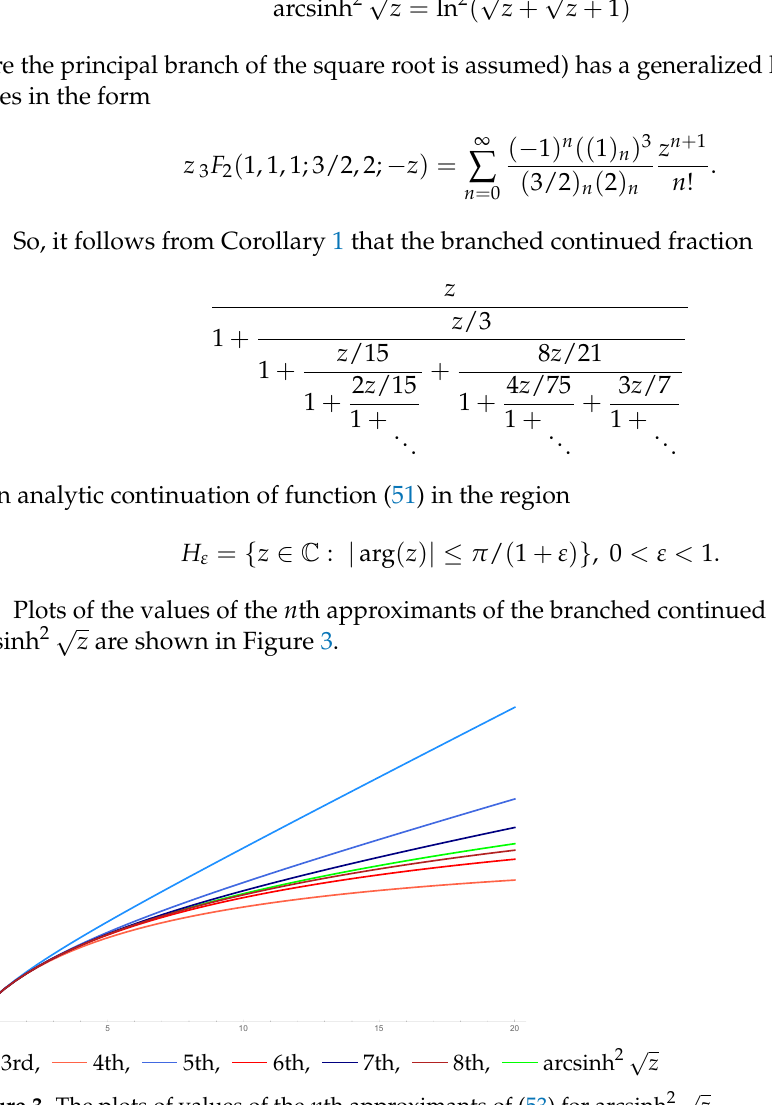
Figure 3. The plots of values of the n th approximants of (53) for arcsinh 2